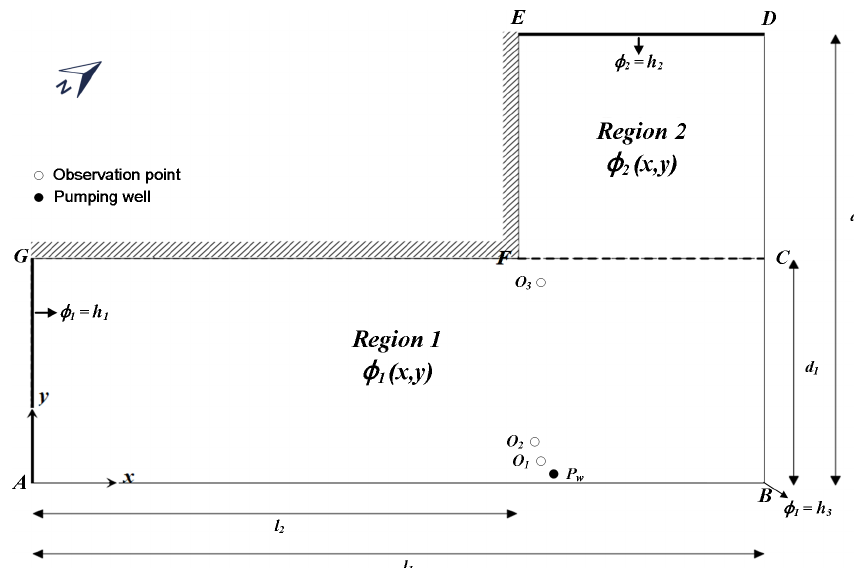
Figure 2. The L-Shaped fluvial aquifer with two